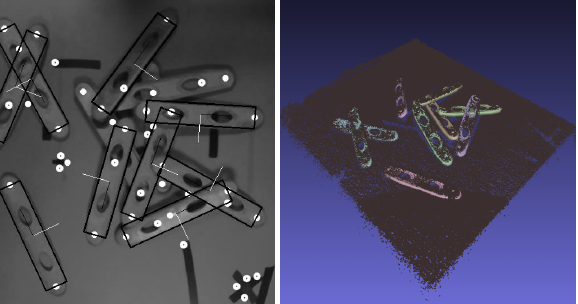
Figure 7. An example of metal pieces localization in